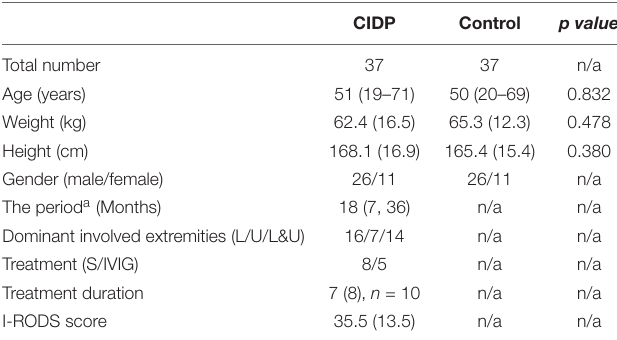
TABLE 1 | Clinical characteristics 1